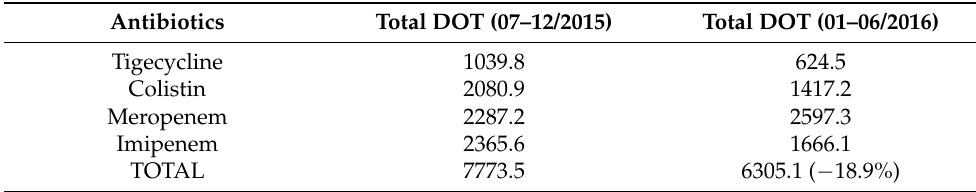
Table 2. Hospital DOT data for July–Dec 2015 (before ASP implementation) and January–June 2016